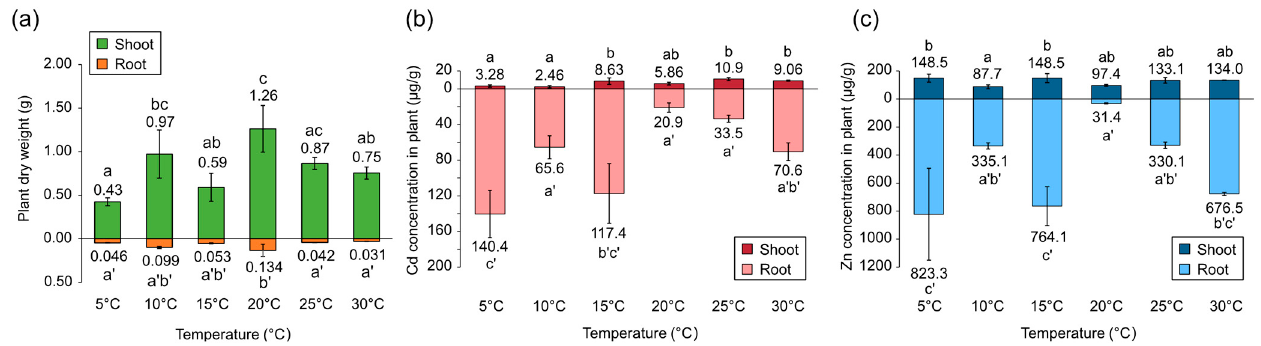
Figure 1. ( a ) Plant dry weights of A. halleri ssp. gemmifera, ( b ) Cd concentration in plants, and ( c ) Zn concentration in plants. The same letters indicate no significant differences between samples according to the Tukey–Kramer test ( p < 0.05).